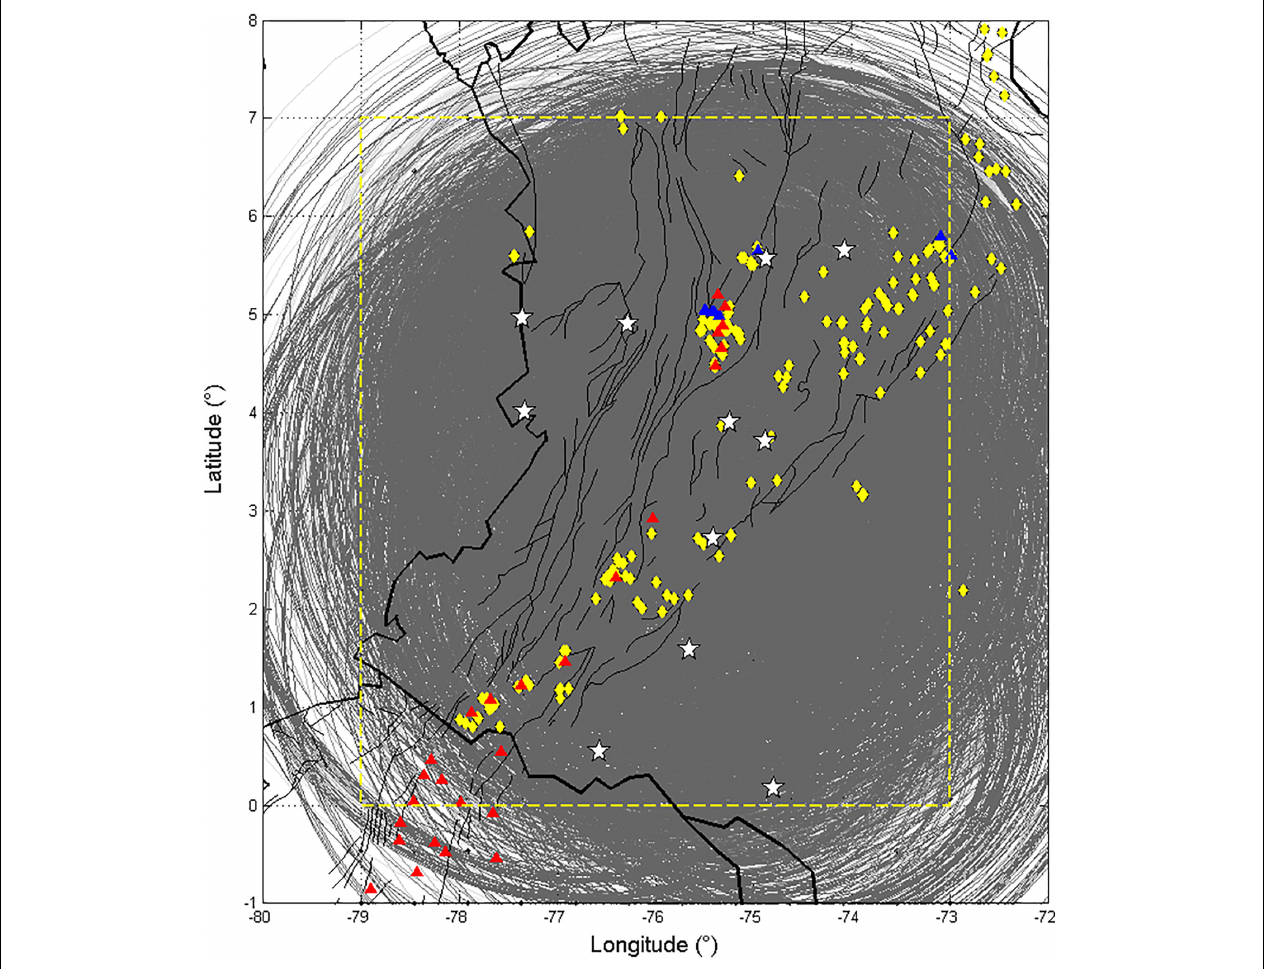
FIGURE 4 | The gray ellipses are horizontal projections of ellipsoids related to the sampled volume during the simple backscattering process (Aki and Chouet, 1975), using as foci each event-station pair. The map highlights the study area where the coda wave attenuation tomography was performed (yellow dashed line), the location of the seismological stations, which data was used (white starts), the volcanic arc (red and blue triangles), the main tectonic faults (black lines) and spring water occurrences (yellow diamonds) reported by the Servicio Geológico